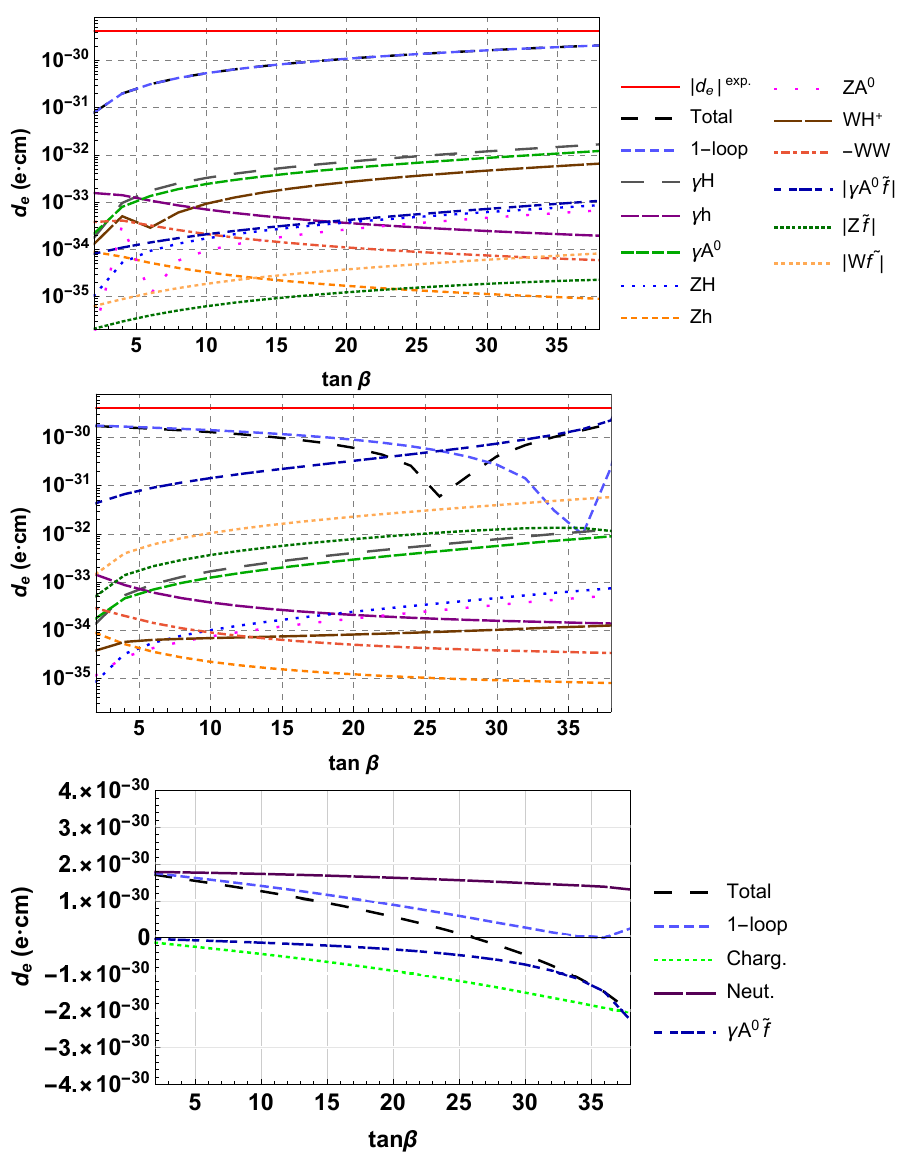
Figure 7 . Comparison of the contributions of 1-loop and 2-loop diagrams as a function of tan β for θ µ /π = 0 . 00015 . m 1 = 8 TeV and m 0 = 8 . 8 TeV (upper plot) and θ A /π = 0 . 025 for m 1 = 8 TeV / 2 / 2 and m 0 = 8 . 8 TeV (middle plot). It is well known that the leading 2-loop contribution comes from the diagram γA 0 ˜ f , specially for large tan β and θ A = 0 . To visualize the interplay of the 6 contributions we have also displayed the contributions from charginos, neutralinos and γA 0 ˜ f for the case θ A /π = 0 . 025 (lower plot). Basically the contributions from charginos and neutralinos tend to cancel at large tan β , according to eq. (3.13), and hence when tan β increases the 2-loop contribution from γA 0 ˜ f becomes